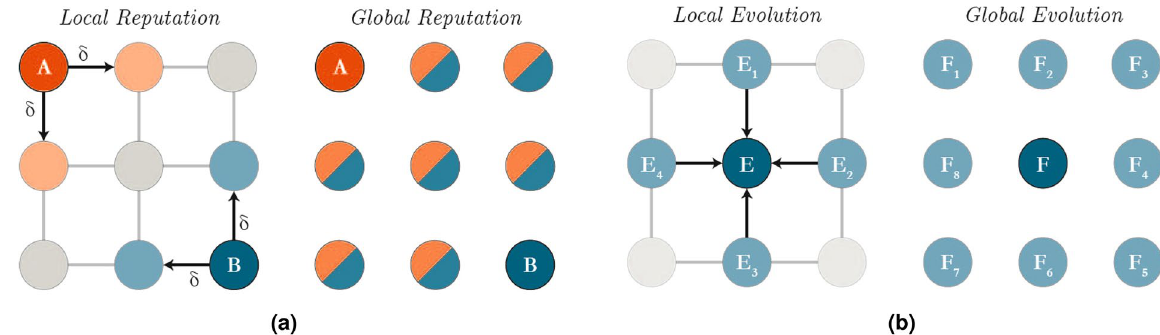
Figure 1. Reputation and evolution mechanisms. ( a ) Suppose agent A and B are chosen to interact with each other. With local reputation , B can only ascertain A ’s reputation from A ’s neighbours. Likewise, A can only ascertain B ’s reputation from B ’s neighbours. These neighbours have probability δ of witnessing each of A and B ’s interactions and their most recent reputation. This is in contrast to global reputation where an agent’s reputation is publicly known information. ( b ) With local evolution , agent E can only view the payoff (and the corresponding strategies) of his neighbours E 1,...,4 and can update to the strategy that results in the greatest payoff in his neighbourhood with probability α. With global evolution, agent F can analyse the entire population, in this case F 1,...,8, and find the strategy with the greatest average payoff amongst agent running that strategy.